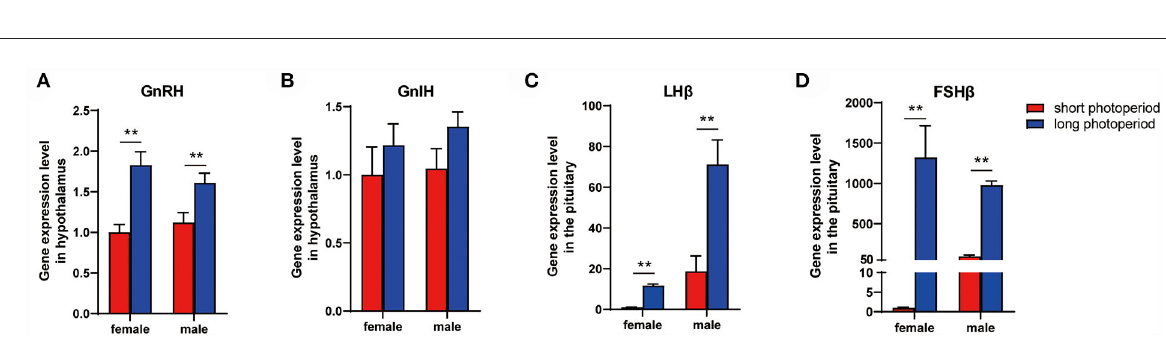
FIGURE5 GnRH, GnIH, LH β , and FSH β expression during different photoperiods. mRNA level of GnRH (A) , GnIH (B) , LH β (C) , and FSH β (D) under different photoperiod. Data are expressed as mean ± SEM ( n = 3). ** P <